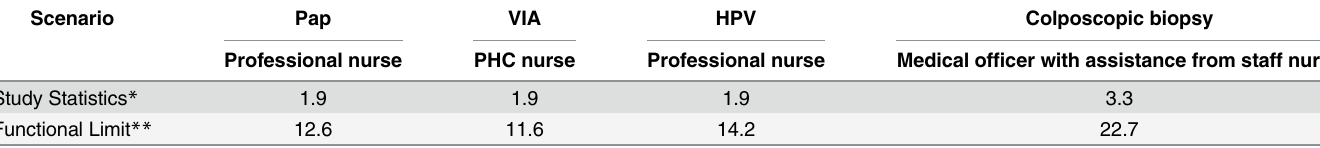
Table 2. Caseload scenarios: Total procedures possible per day per study nurse or